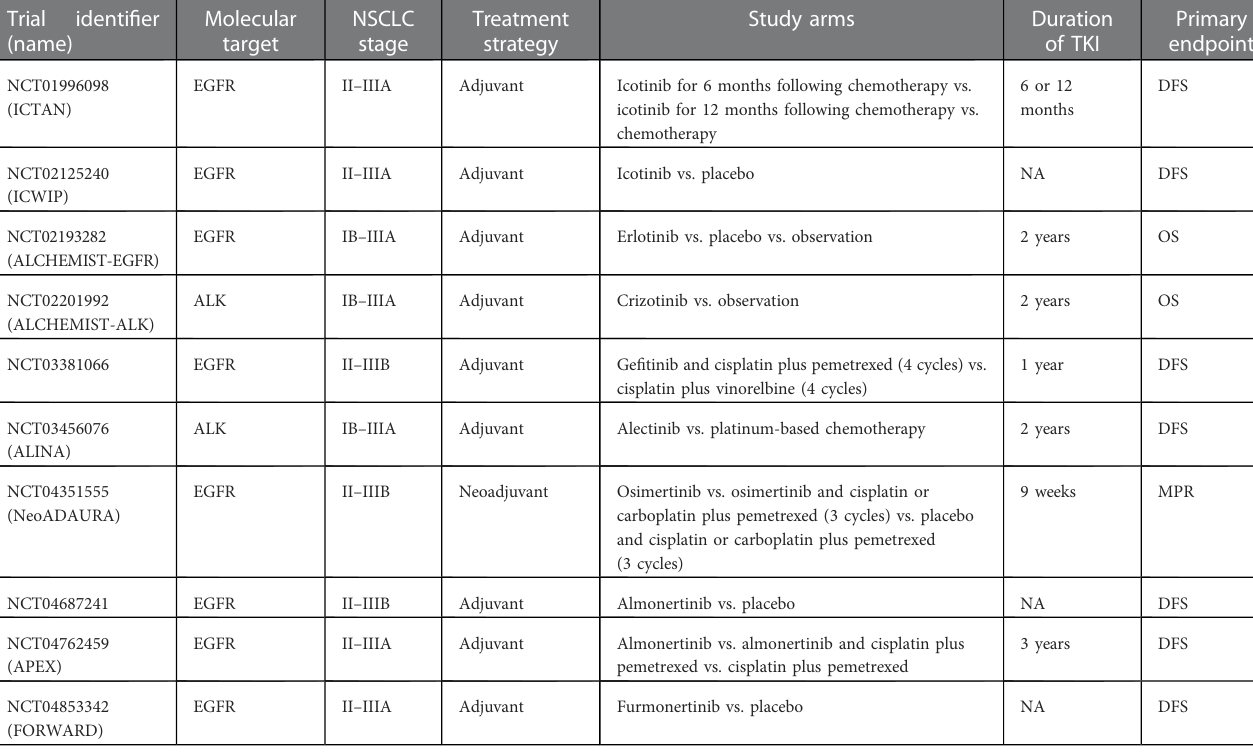
TABLE 2 Current phase 3 randomized clinical trials of tyrosine kinase inhibitors as adjuvant and neoadjuvant treatment for non-small-cell lung cancer.